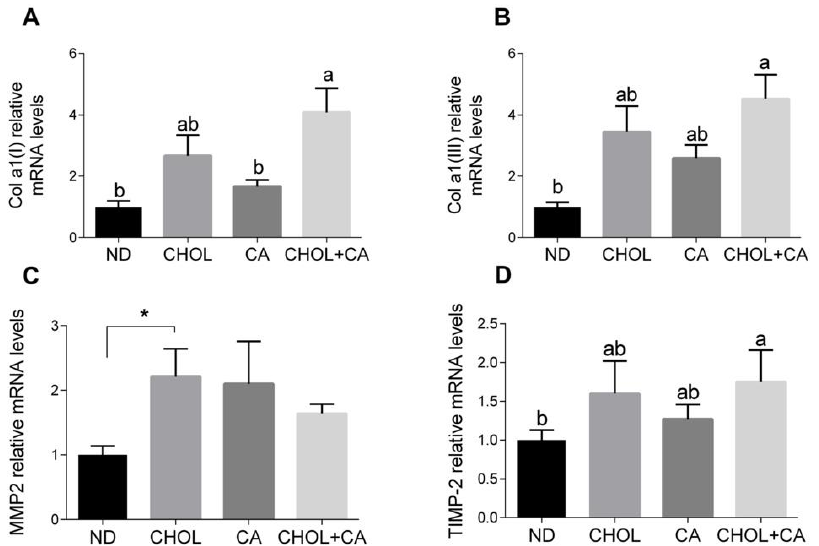
Figure 3. Effect of dietary cholesterol and bile acids on ECM genes. Male C57BL/6J mice aged four to five weeks were fed: ND—normal diet ( n = 10), CHOL—cholesterol diet ( n = 10), CA—cholic acid diet ( n = 9), CHOL + CA—cholesterol + cholic acid diet ( n = 8) for six weeks. ( A ) Col a1(l) relative mRNA levels. ( B ) Col a1(lll) relative mRNA levels. ( C ) MMP2 relative mRNA levels. ( D ) TIMP-2 relative mRNA levels. All values are expressed as mean ± SEM; columns marked with * are different from control according to Student’s t -test ( p < 0.05); columns marked with different letters (a, b) are significantly different ( p < 0.05) in Tukey-Kramer post-hoc test.